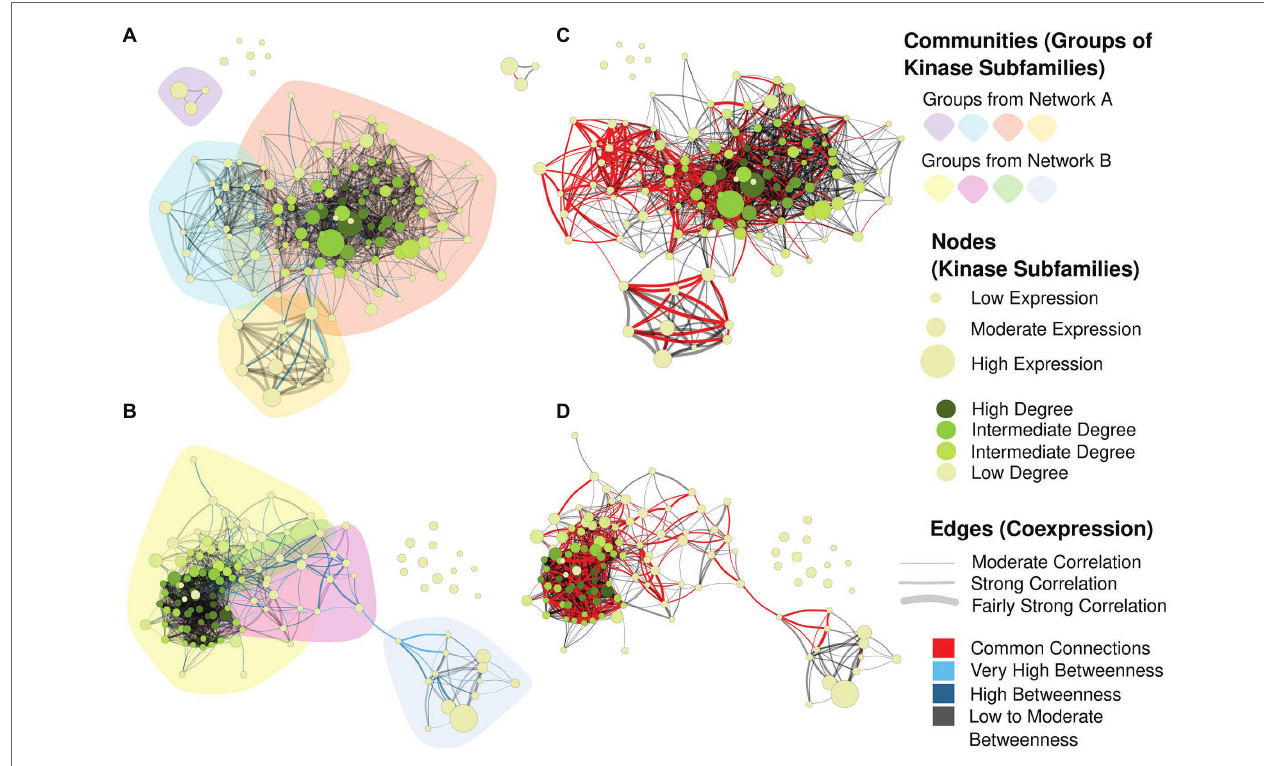
FIGURE 8 | Coexpression networks for Sbi and Ssp kinase subfamilies. Each node corresponds to a different subfamily, its size corresponds to the average expression value for all kinases within the subfamily in different samples, and its color corresponds to the hub score and ranges from beige to dark green. Each edge corresponds to a correlation with a Pearson correlation coefficient of at least 0.6. The correlation strength is represented by the edge’s width and the edge betweenness score is represented by the color (ranging from black to light blue, with light blue representing the highest values). (A) Sbi network with the background colored according to the community detection analysis. (B) Sbi network indicating the similarities with the Ssp network in red. (C) Ssp network with community structure information. (D) Ssp network indicating the similarities with the Sbi network in